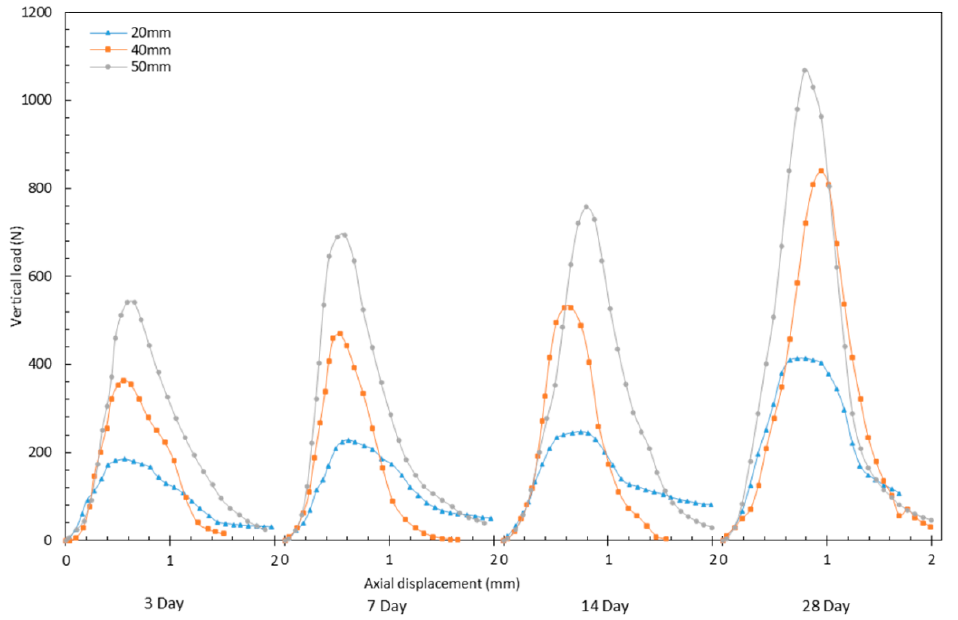
Figure 8. Load displacement curve of 9.7% CPB.